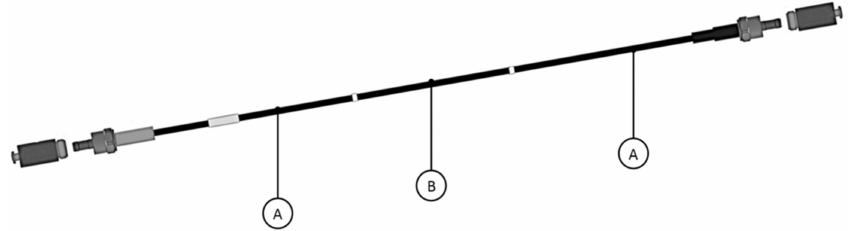
Figure 2. IVISCAN ® probe. Total length = 650 cm; sensing probe B length (delimited by the two white marks) = 200 cm. Lengths of the light guides A = 120 cm (left side) and 330 cm (right side). Each end has an SMA